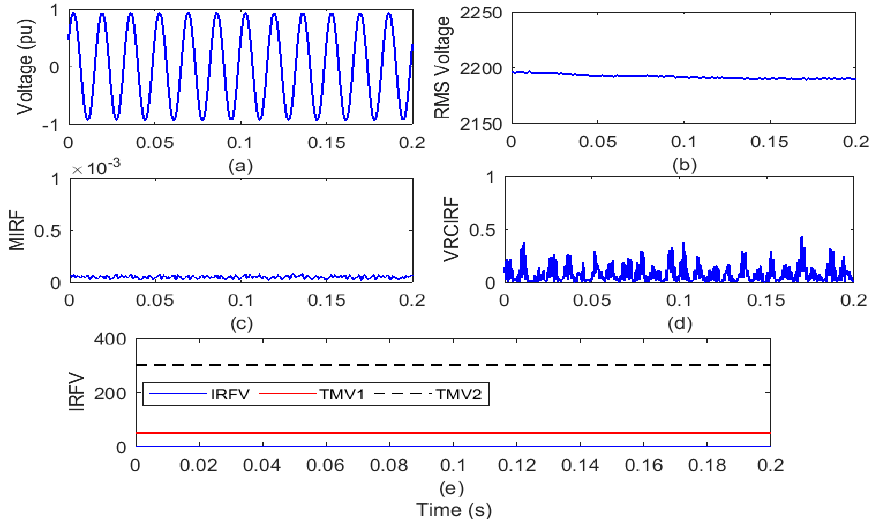
Figure 3. Healthy condition ( a ) voltage signal ( b ) root means square value of voltage ( c ) median-based islanding recognition factor (IRF) ( d ) rate of change in voltage-based IRF ( e ) islanding recognition factor based on voltage.